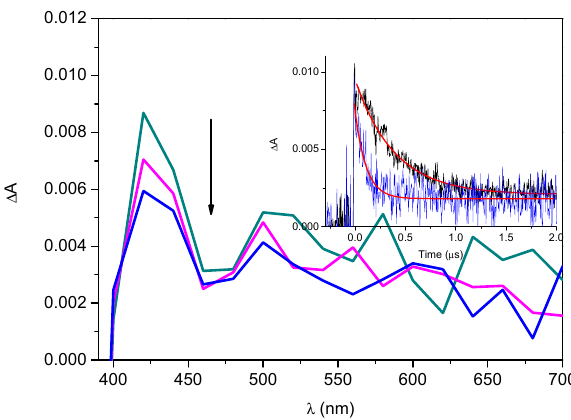
Figure 7. Transient absorption spectra of the AB-DCF dyad (6.4 × 10 − 4 M) in ethanol under N 2 , from 0.1 to 0.27 μ s after the 355 nm laser pulse. Inset: decays monitored at 420 nm under N 2 (black) or air (blue) and their corresponding fittings (red).